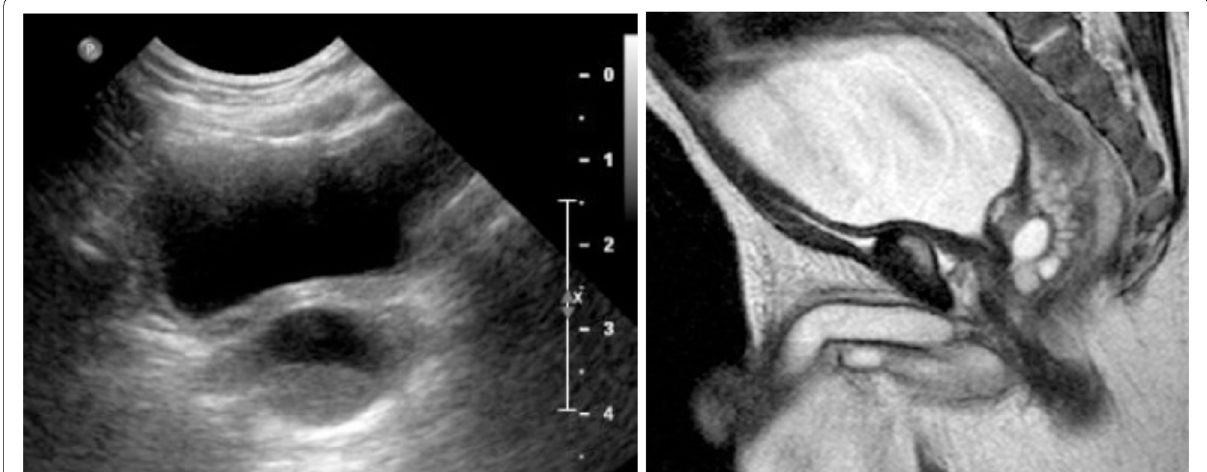
Fig. 1 Ultrasound picture of prostatic utricle and MRI of retrovesical